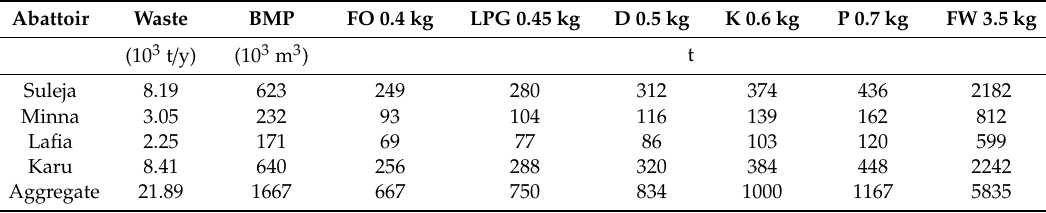
Table 4. Estimation of equivalence of biogas potentials with some fossil fuels in the same function. Abattoir